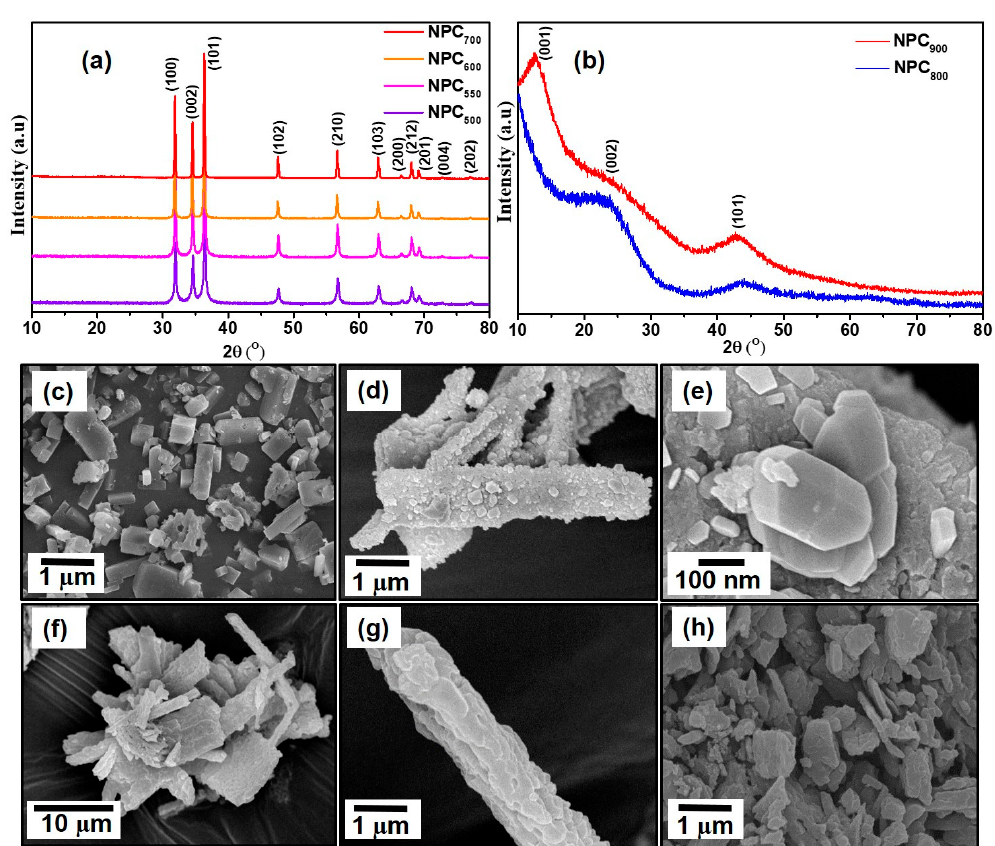
Figure 2. ( a , b ) PXRD patterns NPC samples. SEM images of, ( c ) synthesized Zn-MOF at the 1 µ m scale (before carbonization), ( d – h ) Zn-MOF after carbonization at different temperature. ( d ) NPC 600 at the 1 µ m scale, ( e ) NPC 600 at the 100 nm scale, ( f ) NPC 800 at the 10 µ m scale, ( g ) NPC 800 at the 1 µ m scale and ( h ) NPC 900 at the 1 µ m